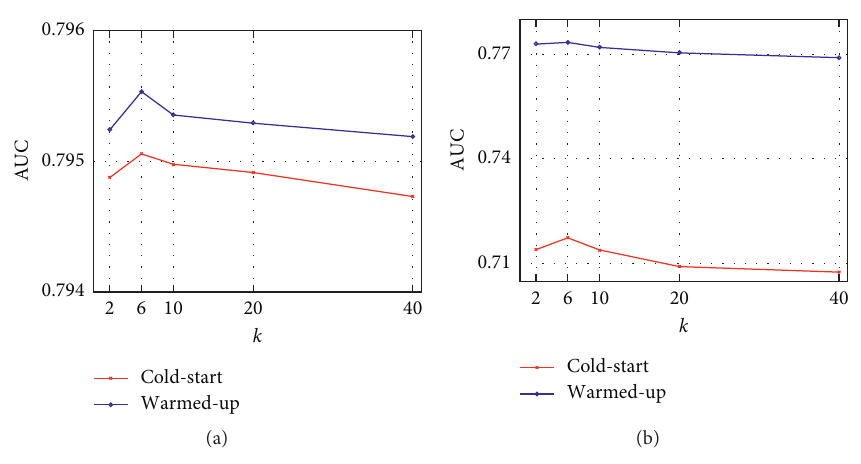
Figure 3: Parameter sensitivity of k on two datasets. (a) Book-Crossing. (b) MovieLens.